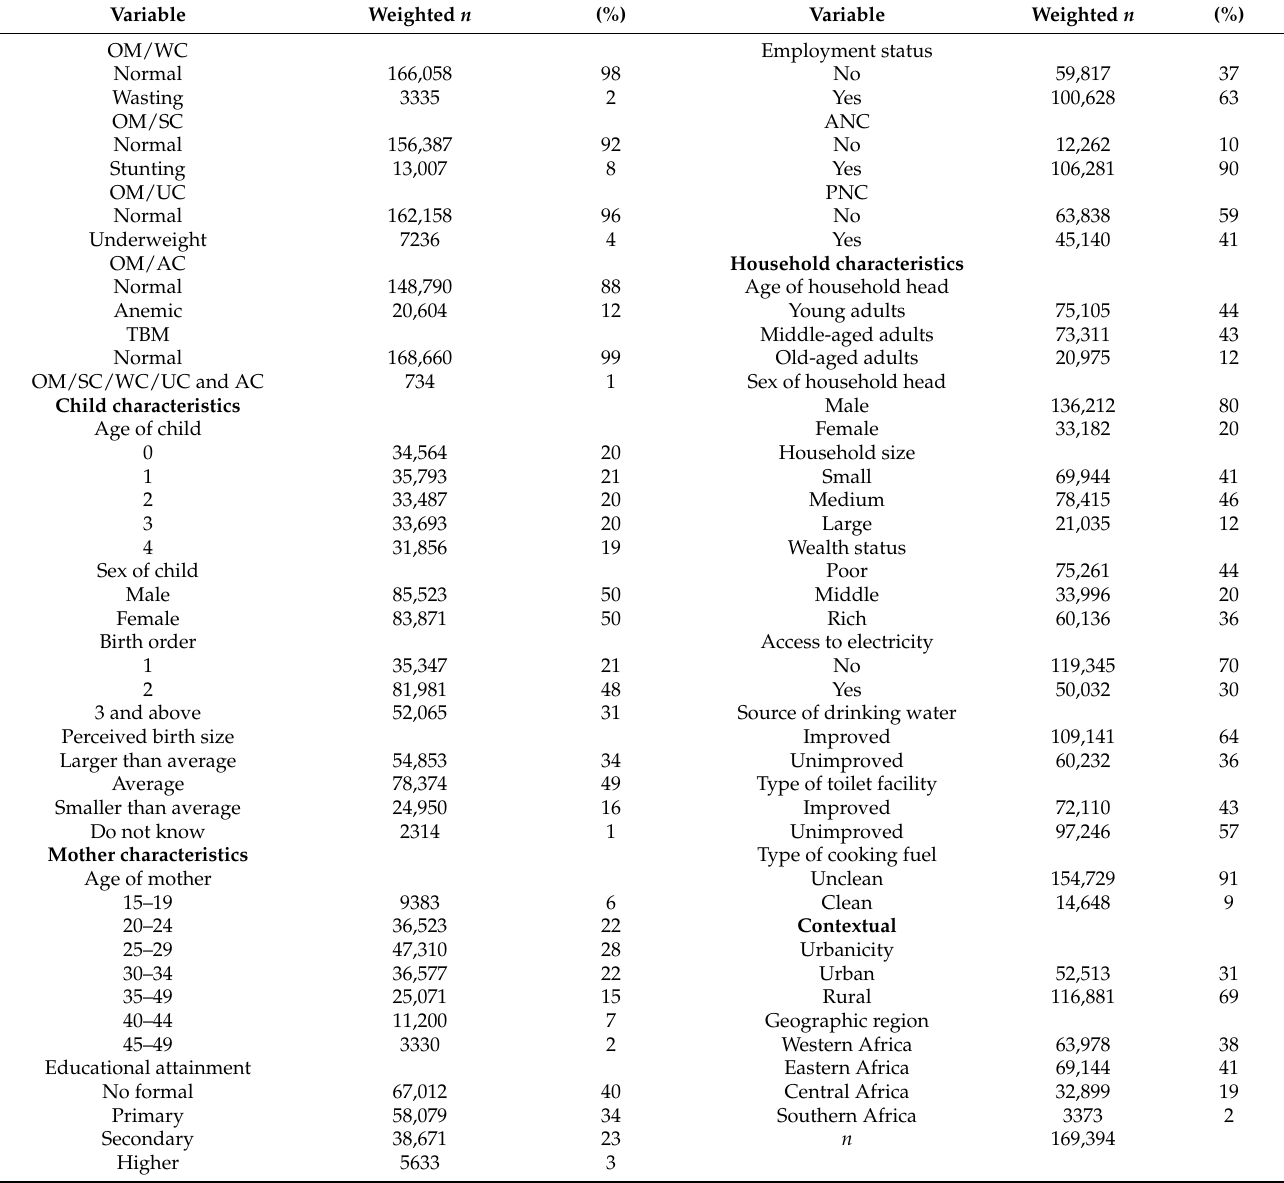
Table 1. Distributions of child, mother, household and contextual